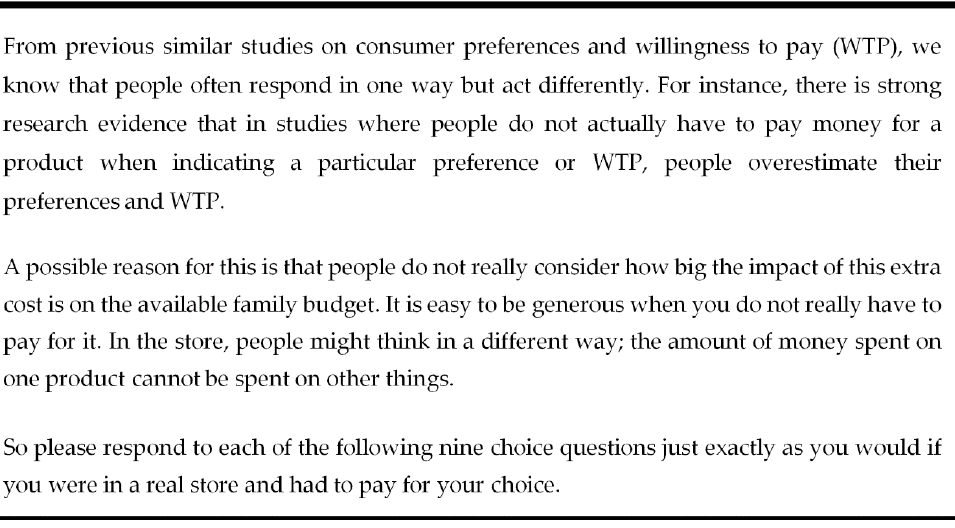
Figure 2. The cheap talk script used in this study.